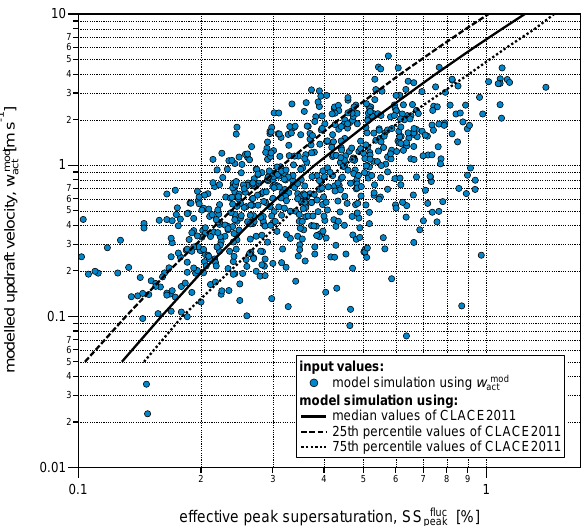
Figure 9. Same as Fig. 3 but the relationship between the modelled updraft velocity ( w mod act ) and effective peak supersaturation taking into account the small-scale fluctuations (SS fluc